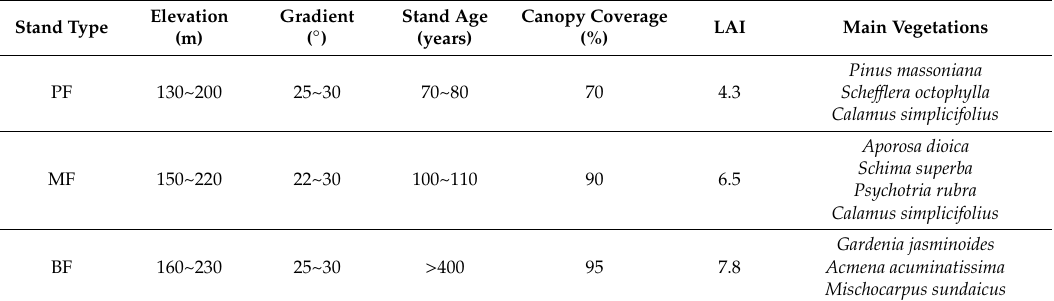
Table 1. Basic description of the study